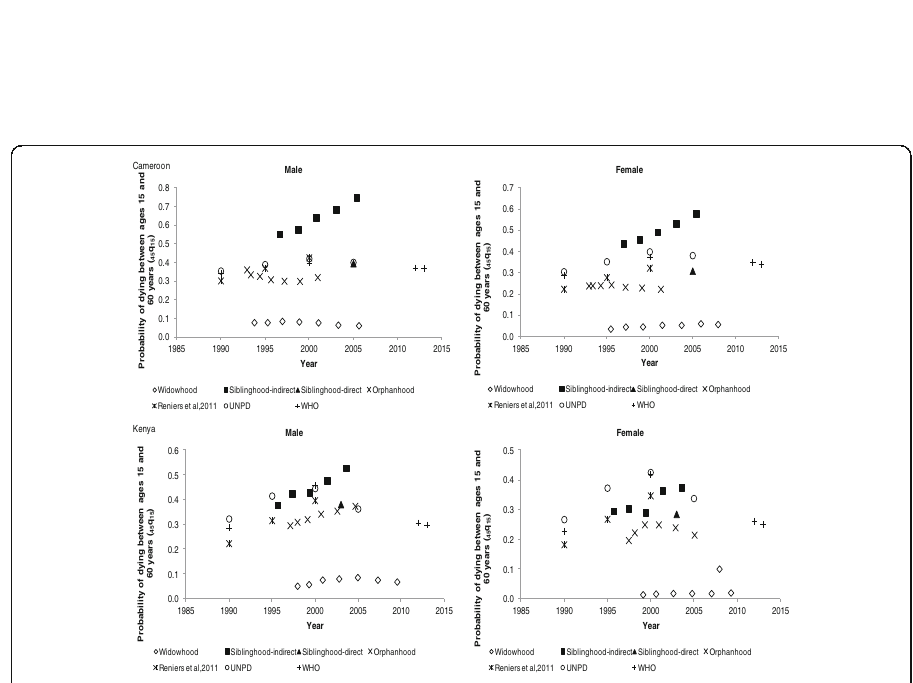
Fig. 2 Probability of dying between ages 15 and 60 years ( 45 q 15 ) by sex in Cameroon and